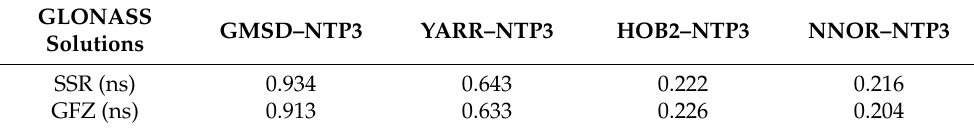
Figure 9. GLONASS results for SSR and GFZ solutions. Table 6. RMS of GLONASS results for the time links